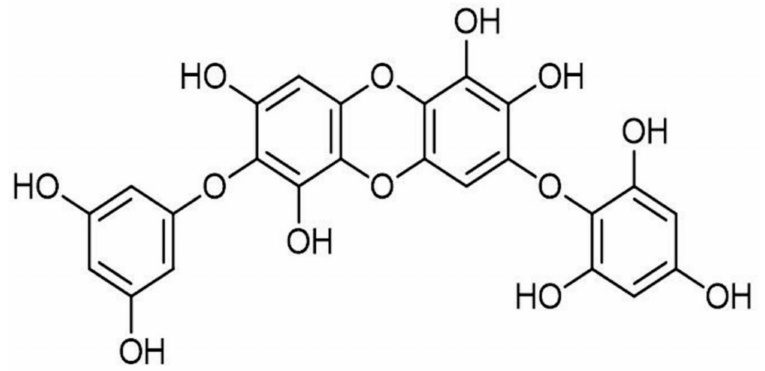
Figure 1. The molecular structure of diphlorethohydroxycarmalol